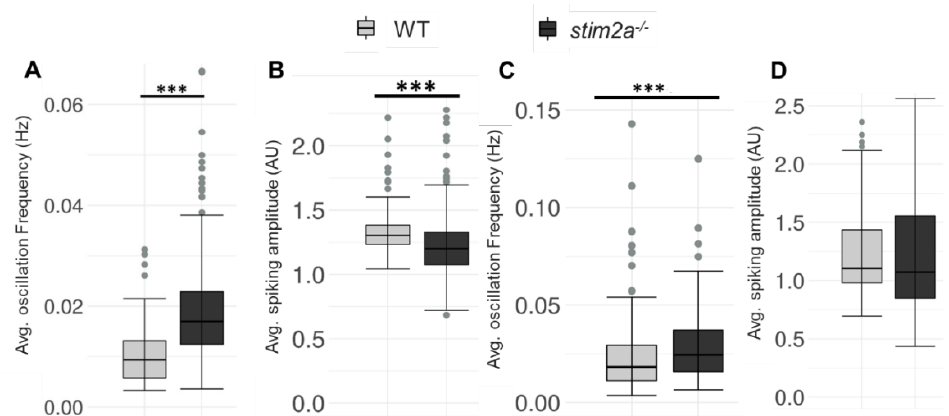
Figure 7. Increase in the spike frequency of neurons in stim2a-deficient zebrafish. For in vivo Ca 2+ imaging, WT and stim2a −/− zebrafish that expressed GCaMP5G under the pan-neuronal HuC promoter were used. Zebrafish neurons from the periventricular gray zone of the optic tectum were analyzed. ( A ) Box plots show the basal level (in E3 water) average oscillation frequency (in Hz). ( B ) The basal level (in E3 water) average calcium oscillation amplitude (AU). Number of cells: 168 WT, 392 stim2a −/− ( C ) Box plots show the average oscillation frequency (in Hz) after treatment with 600 μM glutamate. ( D ) Average calcium oscillation amplitude (AU) after treatment with 600 μM glutamate. Number of cells: 276 WT, 166 stim2a −/− . The Wilcoxon rank-sum test was performed to compare in vivo Ca 2+ responses of the brain between WT and stim2a −/− animals. Number of animals: 3 WT, 7 stim2a −/− . *** p < 0.001.